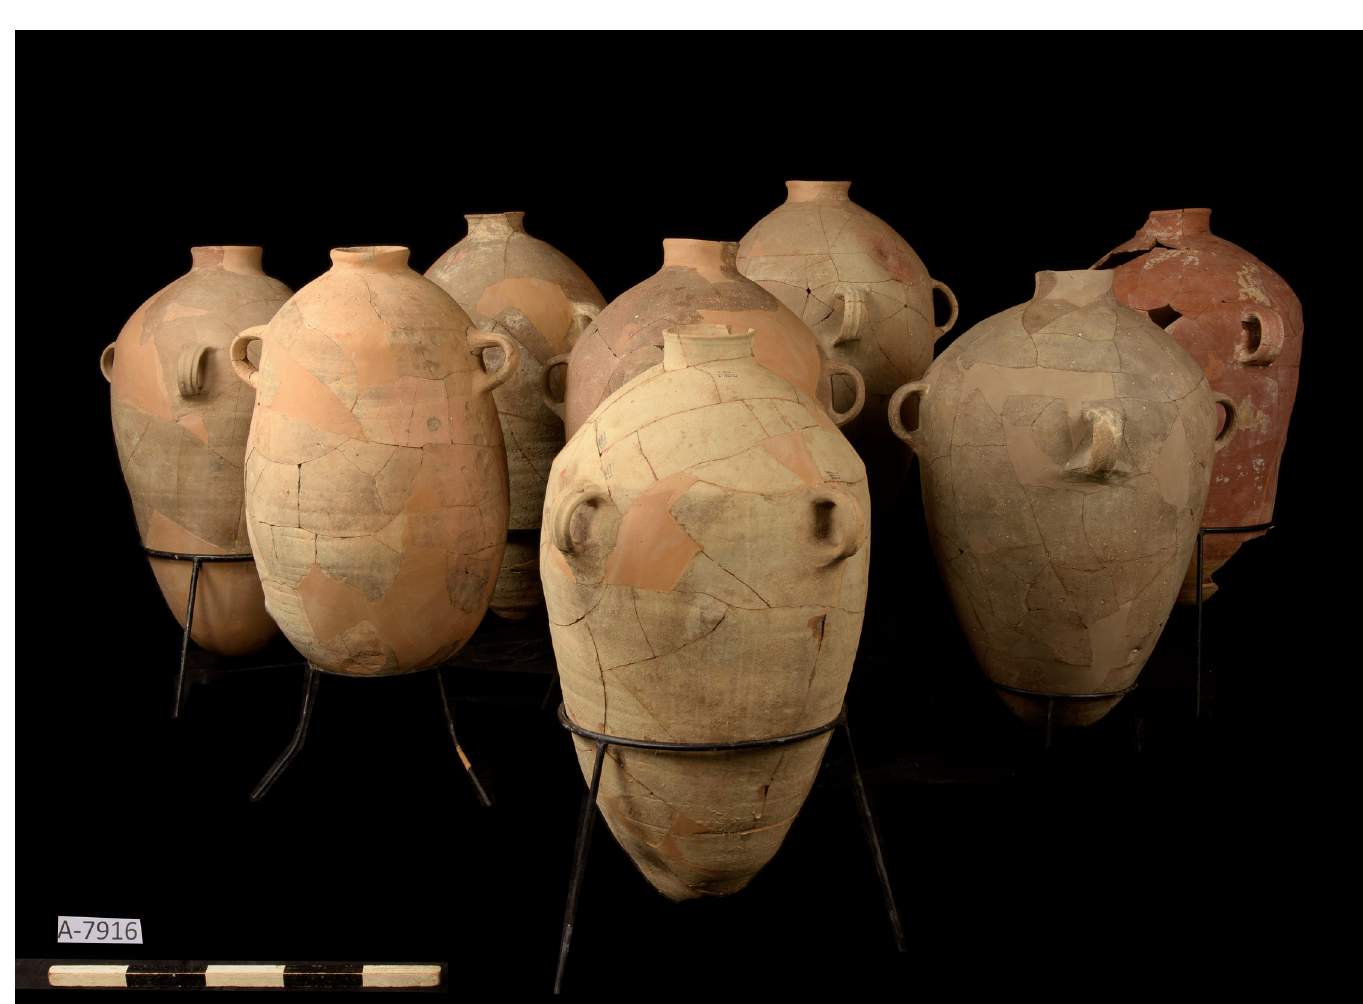
Fig 3. The assemblage of storage jars found within structure 17049. Photographed by Dafna Gazit, the Israel Antiquities Authority